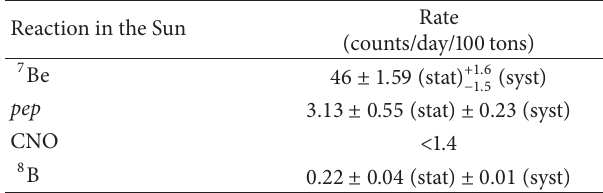
Table 5: Solar-neutrino rates as measured by Borexino. Reaction in the Sun